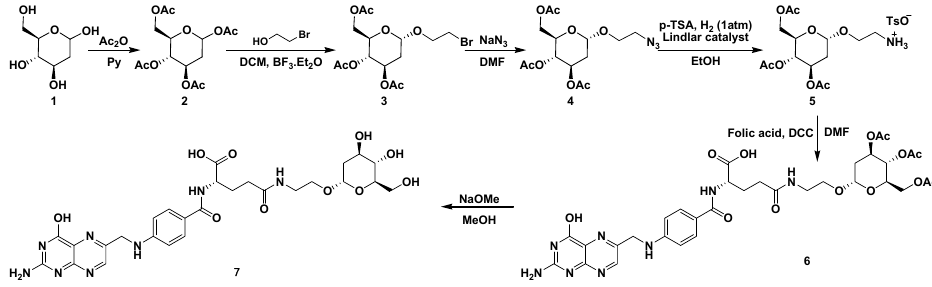
Figure 1. The synthesis route of FA-2-DG. Ac 2 O: acetic anhydride, Py: pyridine, DCM: dichloromethane, DMF: dimethylformamide, DCC: dicyclohexylcarbodiimide.